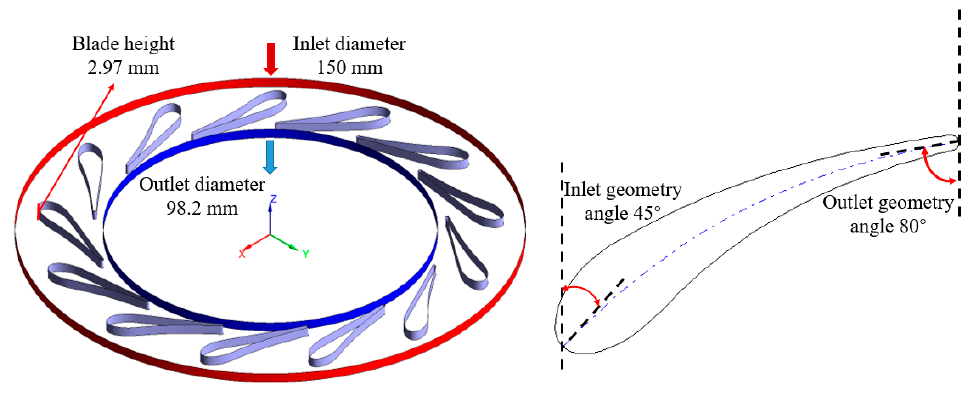
Figure 2. Geometry model of nozzle.